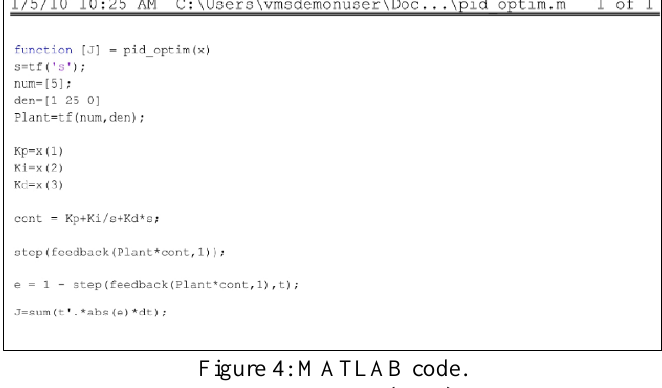
Figure 4: MATLAB